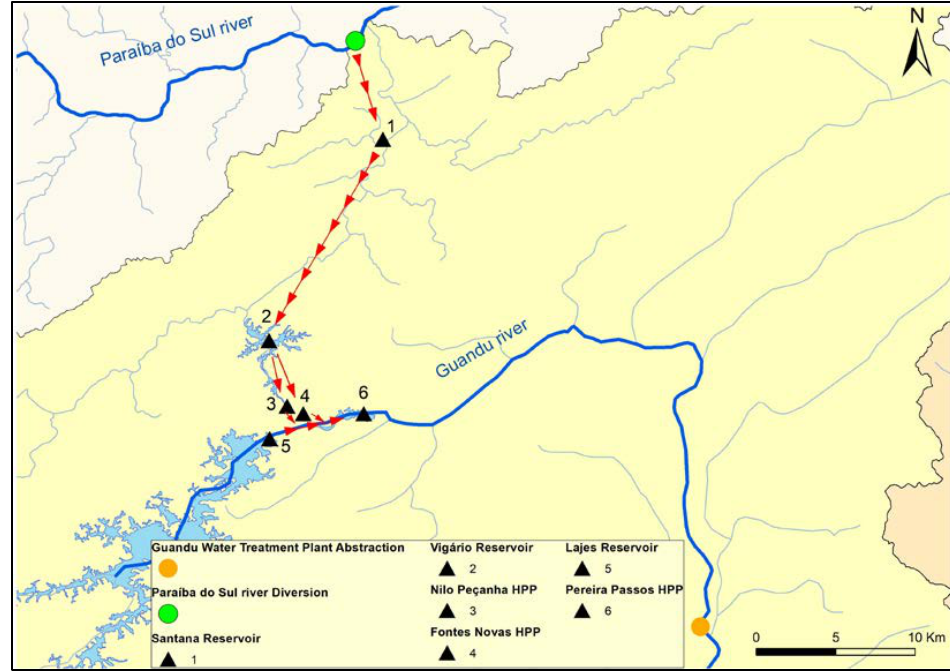
Figure 4. Schematic drawing of the water transfer from Paraíba do Sul to Guandu Rivers.